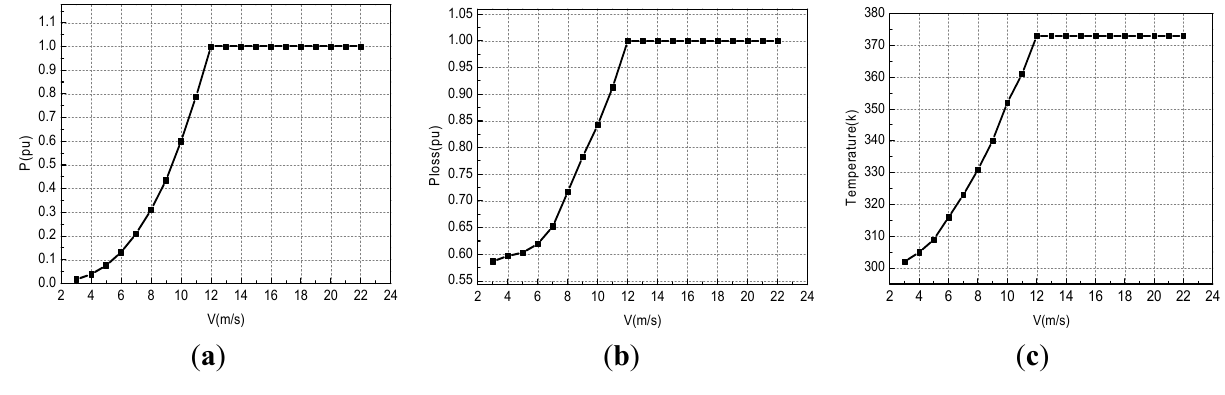
Figure 7. Power curve ( a ); Power loss against wind speed ( b ); Absolute stator winding temperature vs. wind speed ( c ).